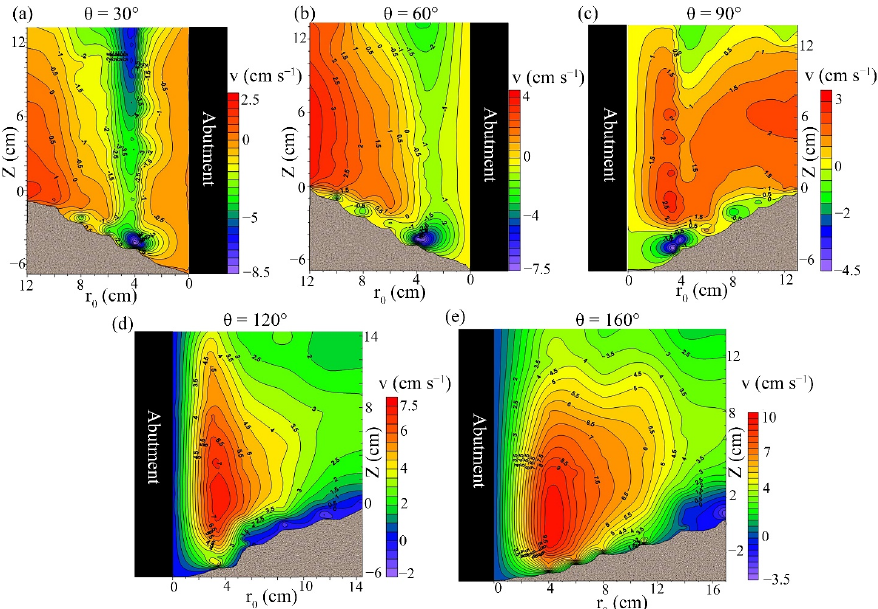
Figure 10. Velocity field in the radial direction ( v , cm/s) for the un-vegetated case at different azimuthal sections of θ . Note that the range of the color scale is not equalized for better illustration.